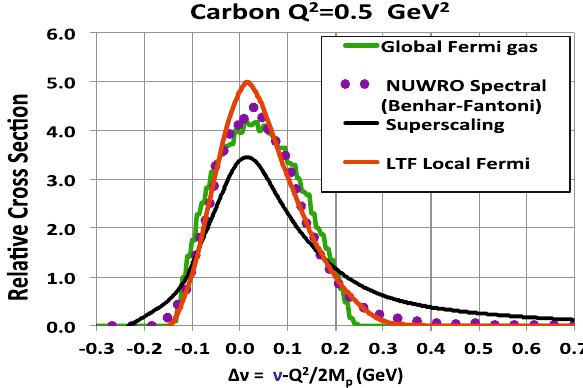
Fig. 2 Comparison of the ψ (cid:2) superscaling prediction (solid black line) ( Q 2 ,ν) at Q 2 = 0 . 5 GeV 2 for for the normalized quasielastic 1 σ d σ d ν C to the predictions with several momentum 10 GeV neutrinos on 12 6 distribution ( ν = E 0 − E (cid:2) ). Here the solid green curve labeled “Global Fermi” gas is the distribution for the Fermi gas model. The red line is thepredictionforthelocalThomasFermi(LTF)gas,andthepurpledots are the prediction using the two dimensional Benhar–Fantoni spectral function as implemented in nuwro nucleons in the nucleus. The on-shell recoil excited [ A − 1 ] ∗ = − k and a spectator nucleus has a momentum p ( A − 1 ) ∗ (cid:6) . The off-shell energy of the mean excitation energy (cid:5) E P (cid:6) x interacting nucleon is E i = M A −